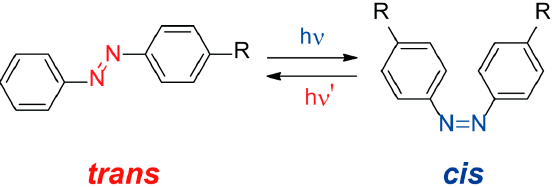
Figure 2. Photoisomerization of an azobenzene compound showing both geometric isomers, trans (shown in red) and cis (shown in blue).